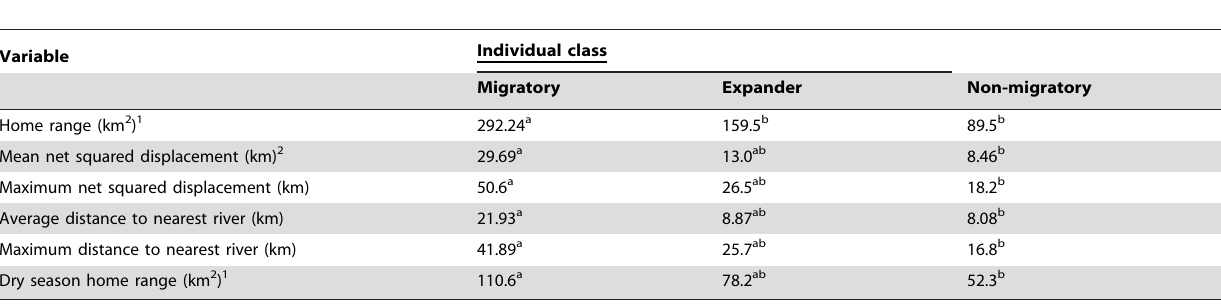
Table 2. Differences in movement metrics among migratory behaviour classes for African buffalo in the Caprivi Strip of Namibia. Differences in superscripts indicate statistically significant differences (Tukey’s post-hoc HSD test).